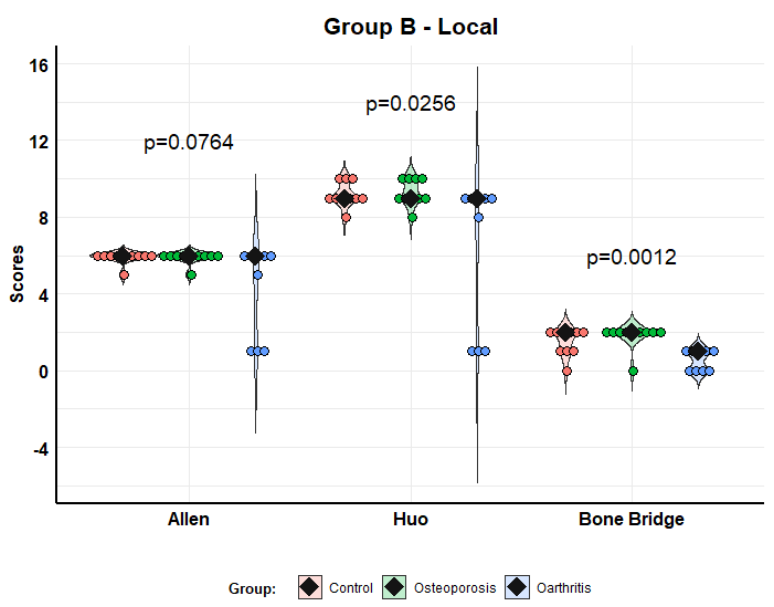
Figure 7. Histological scores according to Allen, Huo and Bone Bridge scales for Model B (local administration). Violin plots with individual values and medians (rhombi).